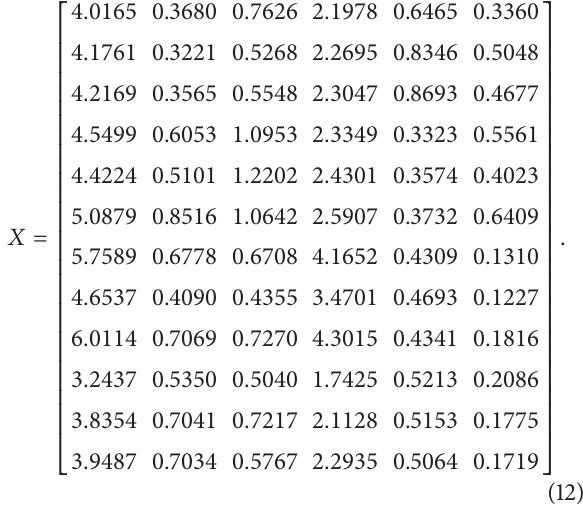
there is a variation rule in the energy distribution of different order band. So, the accumulated energy in the order bands of (0–150), (0–20), (20–60), (60–100), (100–120), and